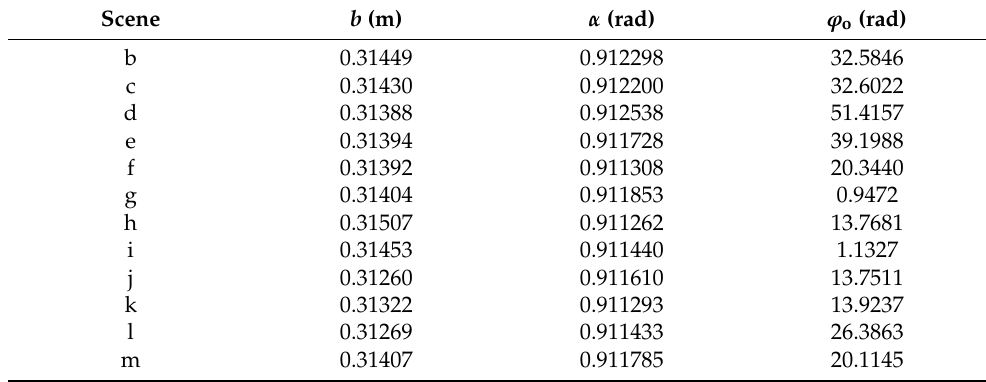
Table 3. Parameter adjustment results of the Qionglai